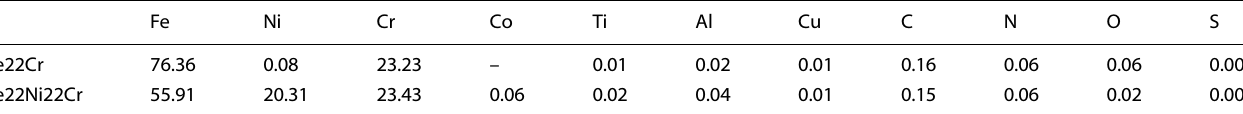
Table 3. Compositions of alloys used in this study